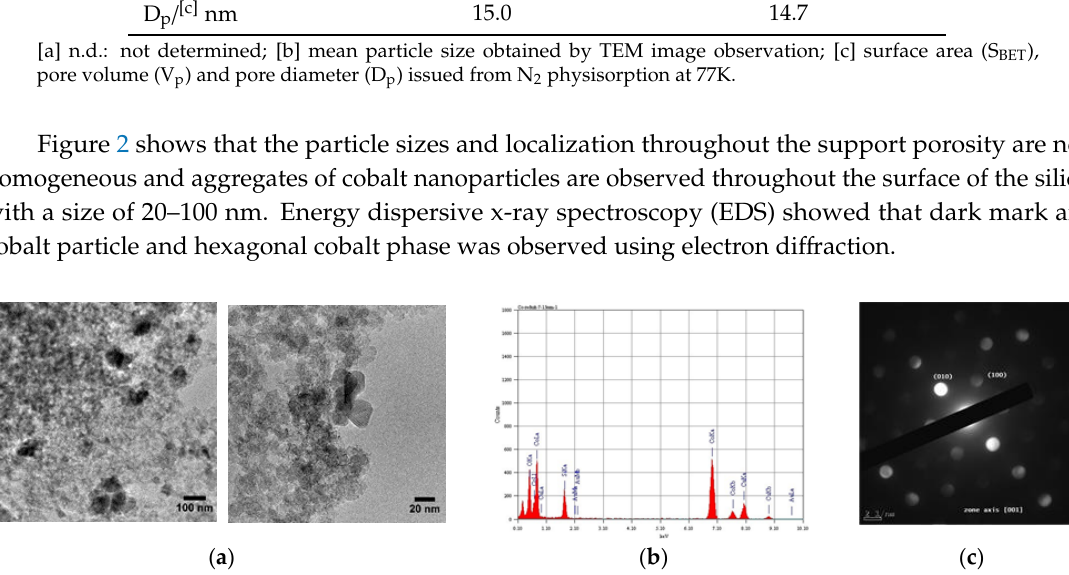
Table 1. Main characteristics of the Co 3 O 4 / SiO 2 and reduced Co / SiO 2 materials.